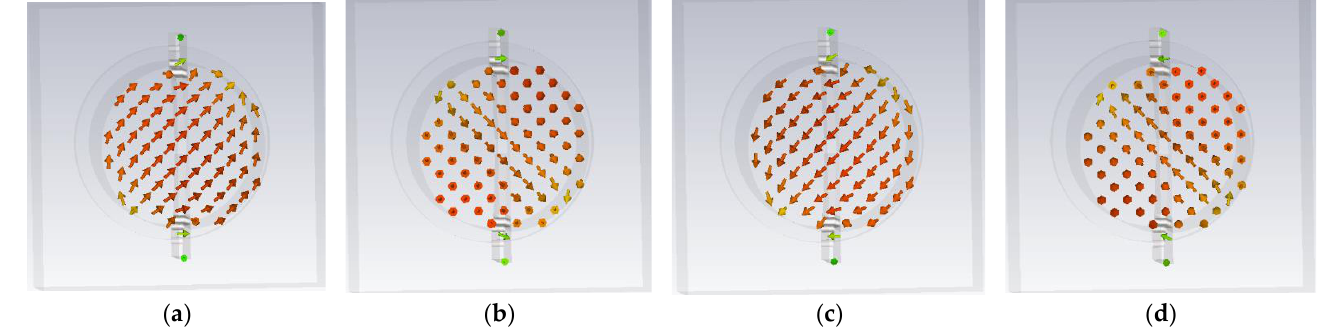
Figure 6. Surface current distributions on port 2 at different phases of time: ( a ) 0°. ( b ) 90°. ( c ) 180°. ( d ) 270°.